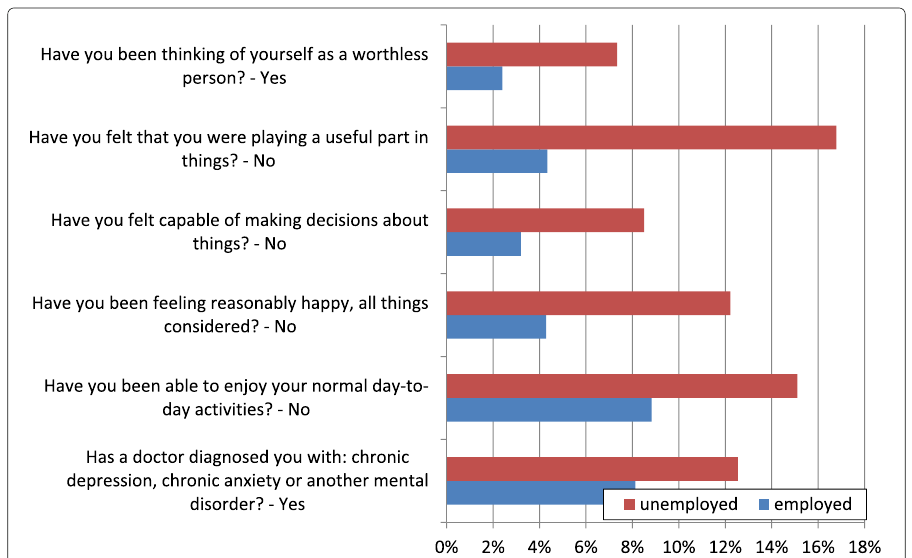
Fig. 1 Unemployment and mental health. Note: Yes and No respectively represent “worse than usual” answers. Source: Spanish National Health Survey. Years 2006 and